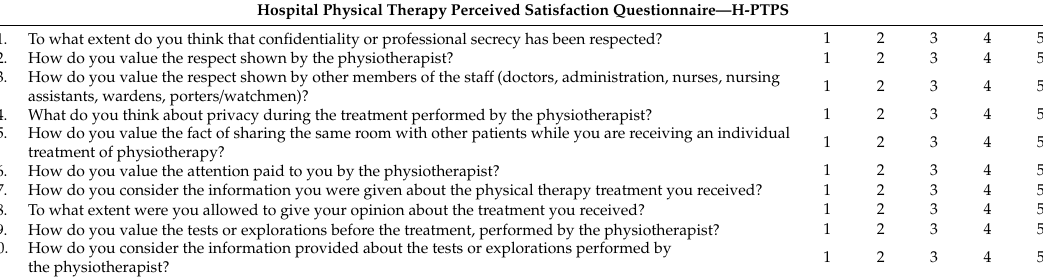
Table 4. Cont. Hospital Physical Therapy Perceived Satisfaction Questionnaire—H-PTPS